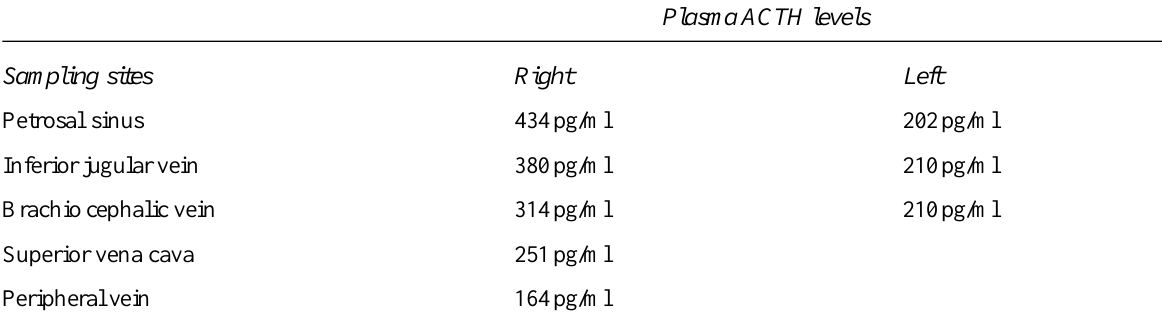
Table 1. Unstimulated petrosal sinus and mediastinal vessels catheterization and sampling demonstrating the ACTH gradient between right and left petrosal sinuses and